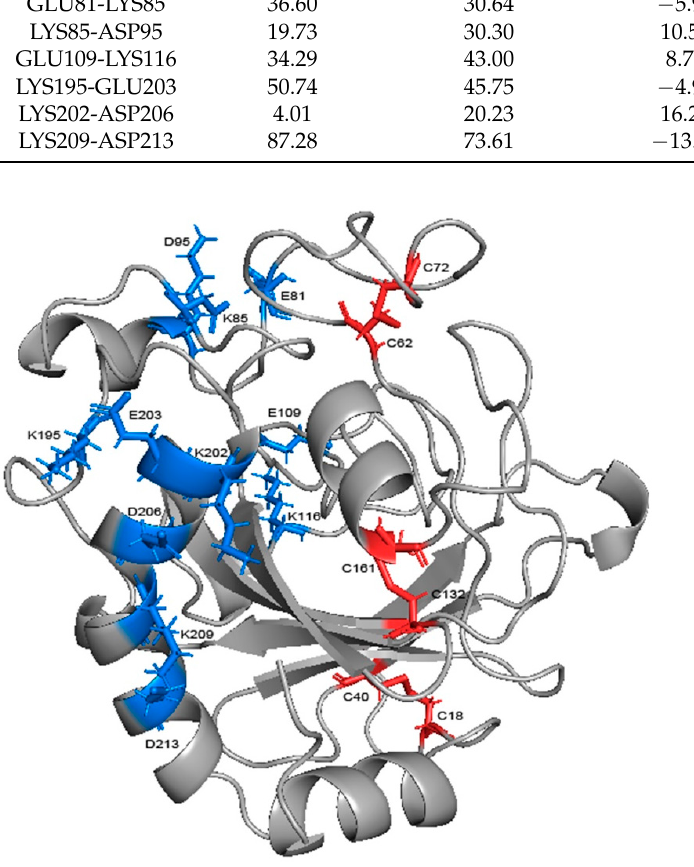
Figure 11. The salt bridges and disulfide bonds in the structure of chitosanase. The blue sticks represent salt bridges and the red ones represent disulfide bonds.